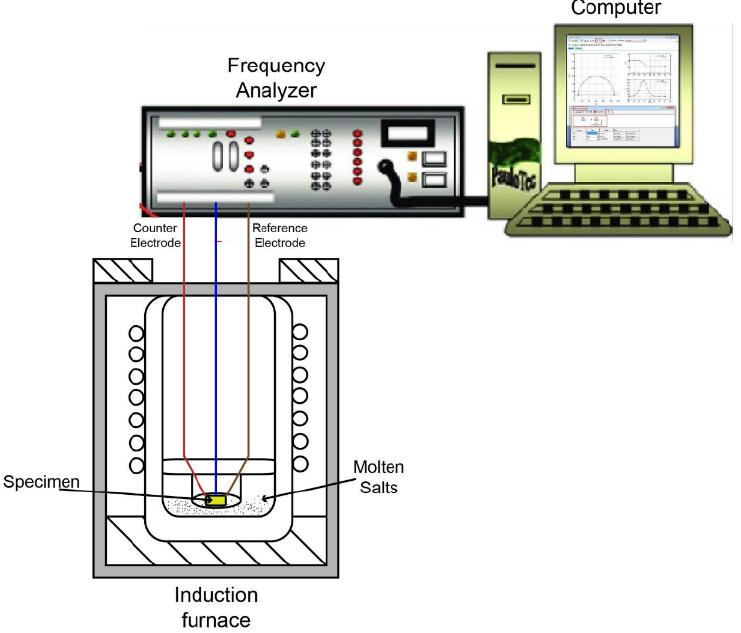
Figure 1. Experimental setup for high-temperature corrosion